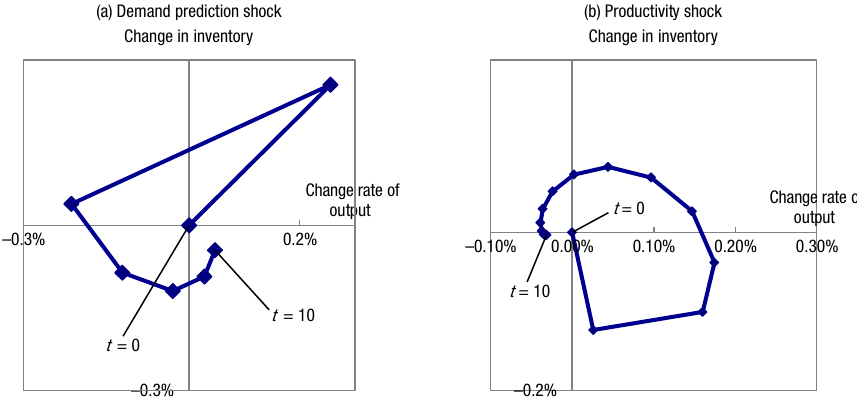
Fig. 5. Simulated inventory cycle in Case